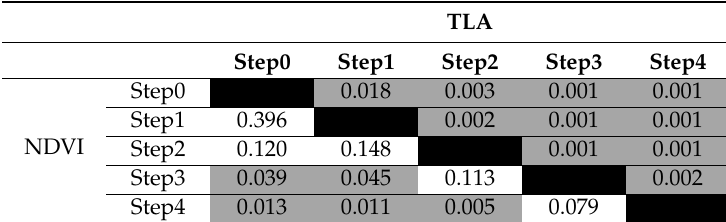
Table 1. p -values from the t -test comparison of Normalized Di ff erence Vegetation Index (NDVI) and total leaf area (TLA) in the field experiment. TLA Step0 Step1 Step2